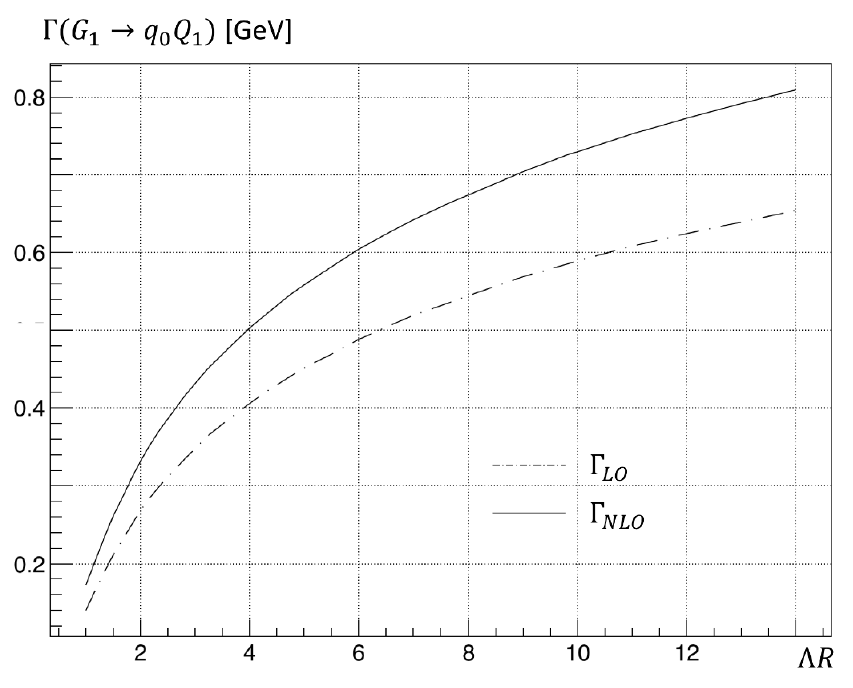
Figure 2 . Full LO and NLO decay width for the level-1 KK-gluon decaying into a regular quark and the level-1 KK-quark within the Coloron model. Both curves exhibit the same (cid:3)